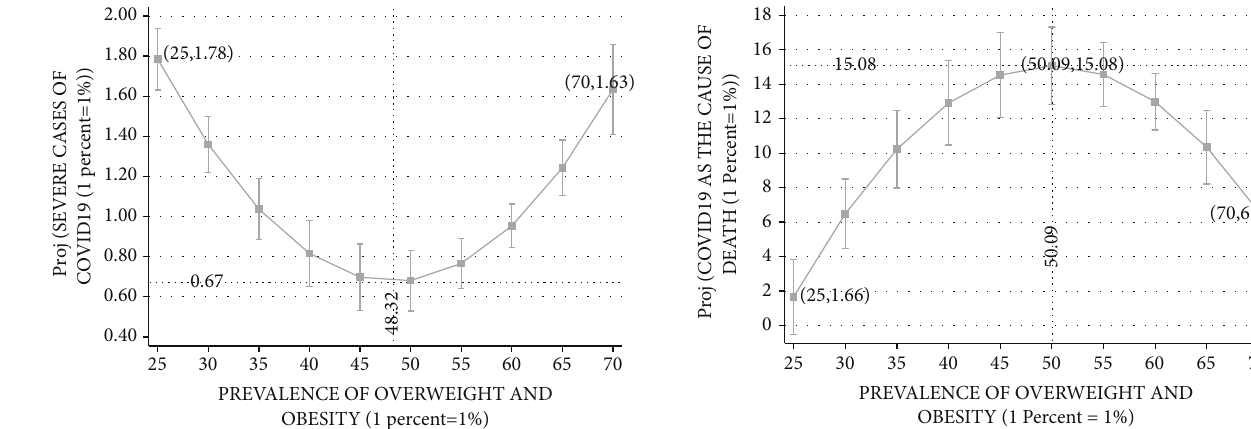
Figure 4: Rate of severe COVID-19 cases vs. prevalence of overweight and obesity. The vertical axis measures the projected probability of severe cases of COVID-19 divided by total cases of COVID-19 in percentage points. The horizontal axis measures the prevalence of overweight and obesity (BMI ≥ 25, where BMI � kg/meter 2 ) in the population of OECD countries based on measured (rather than self-reported) height and weight. The figure is based on the following regression outcomes given in column (1).